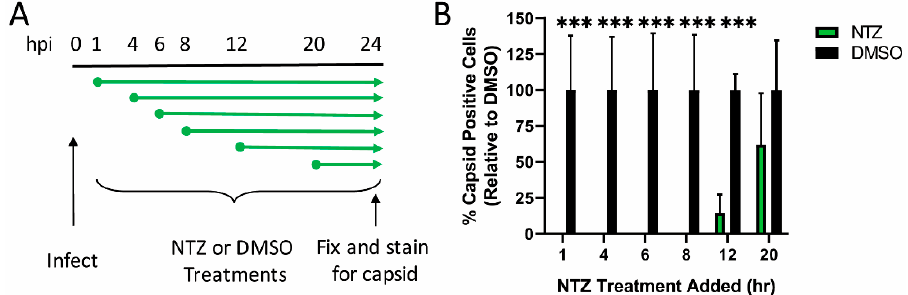
Figure 1. Nitazoxanide effectively inhibits VA1 replication when added up to 12 h post-infection. ( A ) At the indicated times post-infection, nitazoxanide (NTZ; 2.5µM) was added to VA1-infected Caco-2 cells. At 24 hpi, cells were fixed and stained for the presence of VA1 capsid protein. ( B ) The percent of VA1 capsid positive cells for each NTZ treatment was quantitated and compared to vehicle alone (DMSO). All error bars indicate standard deviation of two combined, independent experiments performed in triplicate, and asterisks show statistical significance as measured by multiple t tests as follows: ***, p < 0.001.